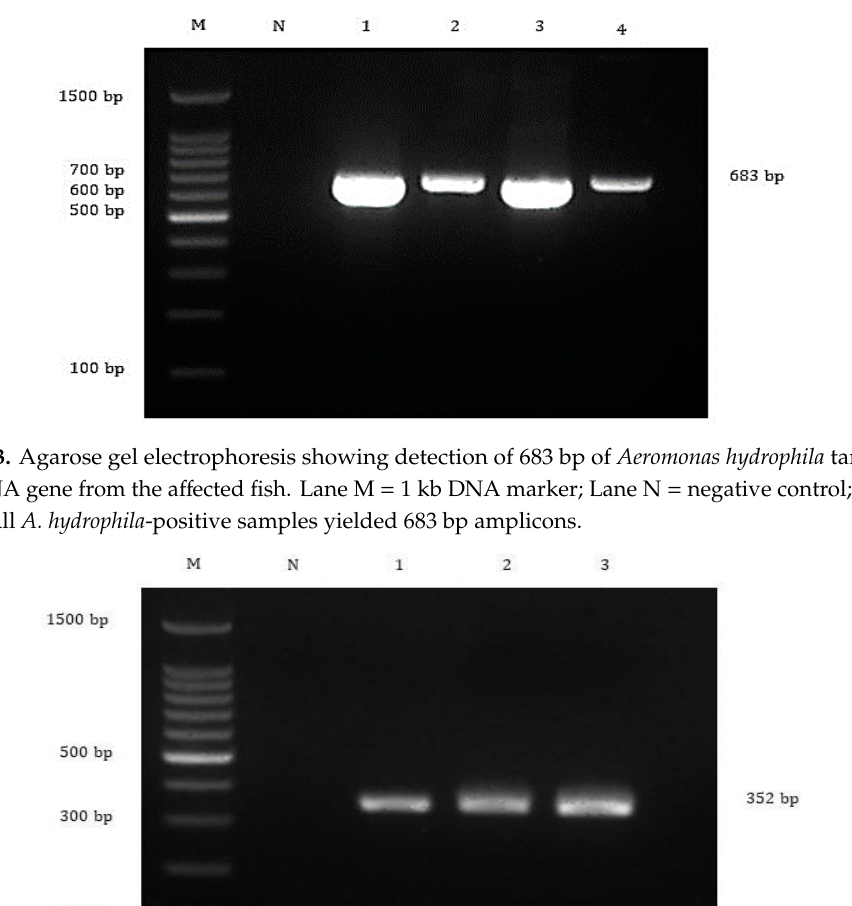
Figure 5. Phylogenetic tree showing the relationship between the three TiLV sequences from the present study, and other reference sequences from Malaysia (MN970195.1), India (MK752932.1), Thailand (KY381578.1), Israel (KJ605629.1) and the United States (MN193515.1). The tree is based on the 250 bp of TiLV’s segment 3. The infectious salmon anaemia virus was considered as an out group.